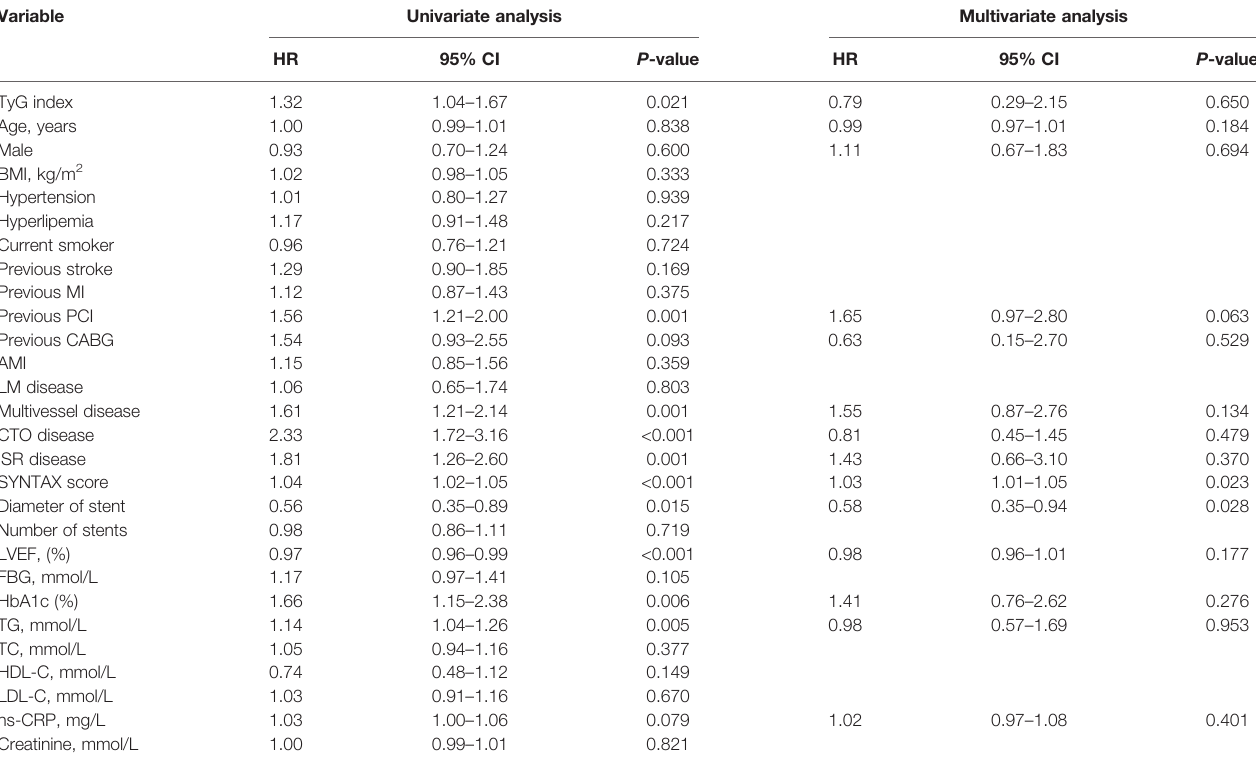
TABLE 4 | Univariate and multivariate Cox regression analyses for predicting the occurrence of MACE.